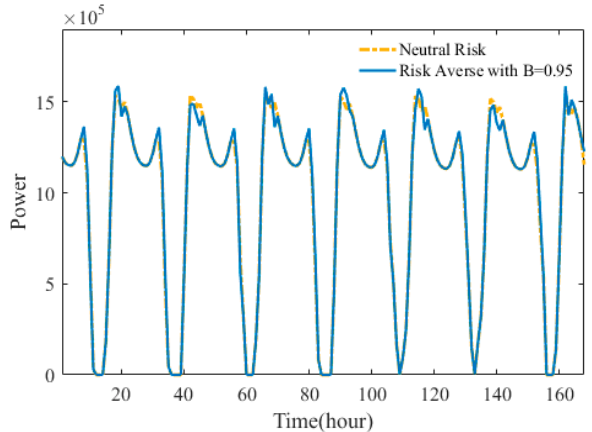
Figure 7. Battery storage level for β = 0.9, β = 0.95, and β = 0.99.